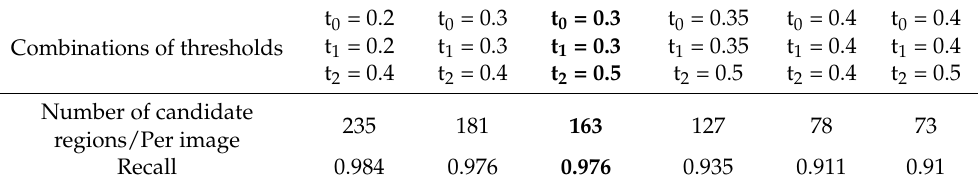
Table 1. The results of region proposal method under different parameter t 0 , t 1 , t 2 settings.